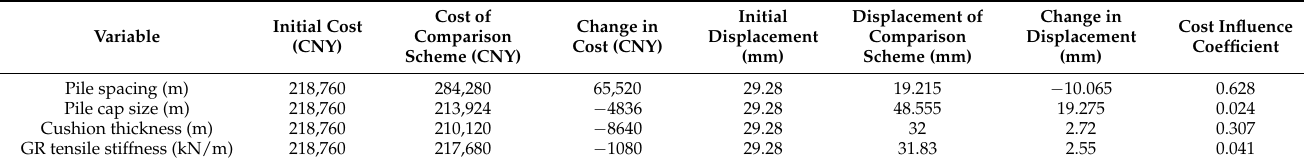
Table 6. Cost influence coefficient for each variable in scheme 1.